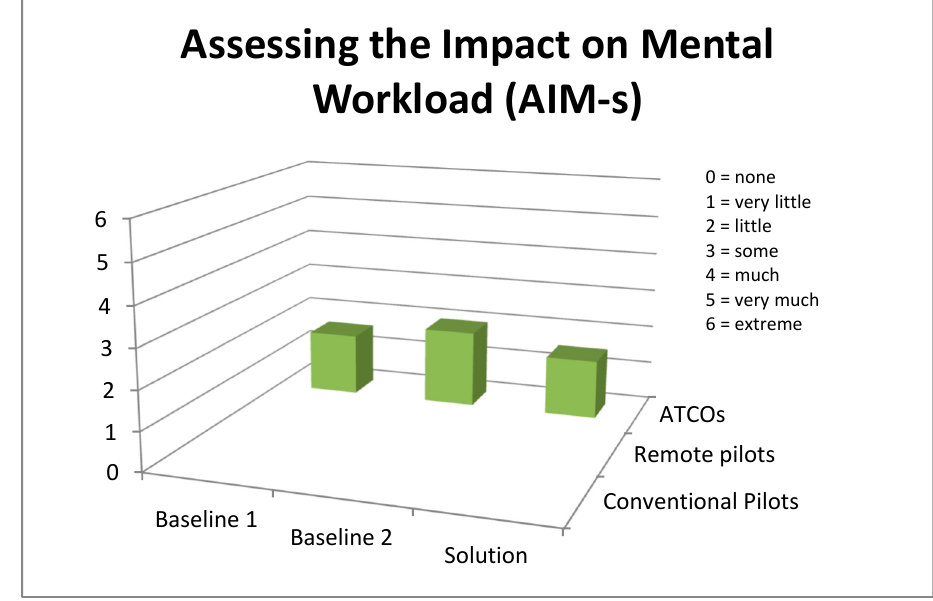
Figure 3. Results of AIM-s questionnaire per scenario, answered by ATCOs.